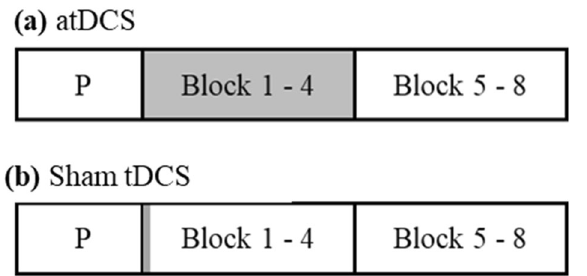
Figure 3. Experimental design. Illustration of atDCS and sham tDCS, which were realized in two sessions, separated approximately by 7 days. ( a ) For atDCS, stimulation began after the practice block and lasted 20 min through blocks 1 to 4 (shaded in grey). The second half of the experiment was not stimulated. ( b ) The stimulation lasted for 30 s in sham tDCS.